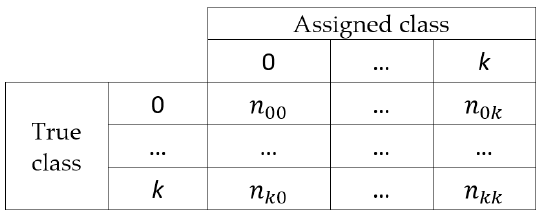
Figure 5. Confusion matrix for a k classes problem.